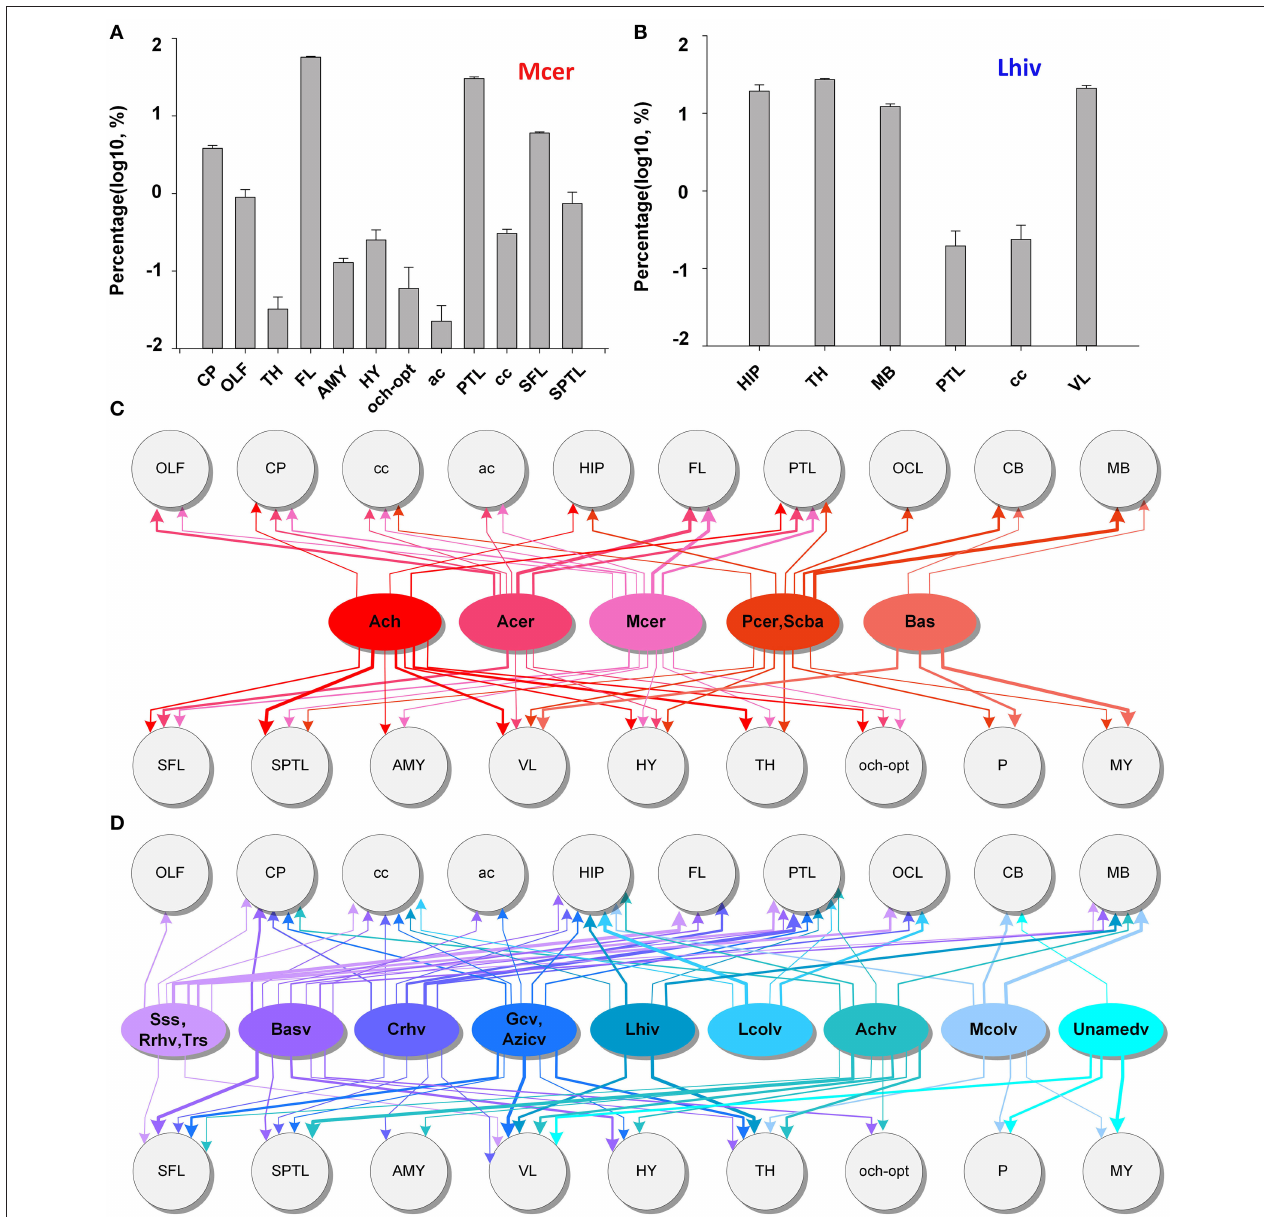
FIGURE 8 | Distributing patterns between the arterial and venous vascular system and brain regions in the whole mouse brain. (A,B) The statistical results for the volume distributions of Mcer and Lhiv within different brain regions. The segmented brain regions are presented on the horizontal axis, and the distribution proportions (after log10 transformation) of vessels in the corresponding brain region are presented on the vertical axis. (C,D) Distributing patterns of arteries and veins with the main brain regions. The lines and arrows between the vessels and brain regions indicate the branches that extend to the brain region, while the line thickness represents the values of distribution proportions. A list of abbreviations and the full names of the brain regions is presented in Supplementary Table 1, while a tree of abbreviations and the full names of vessels is presented in Figure 4